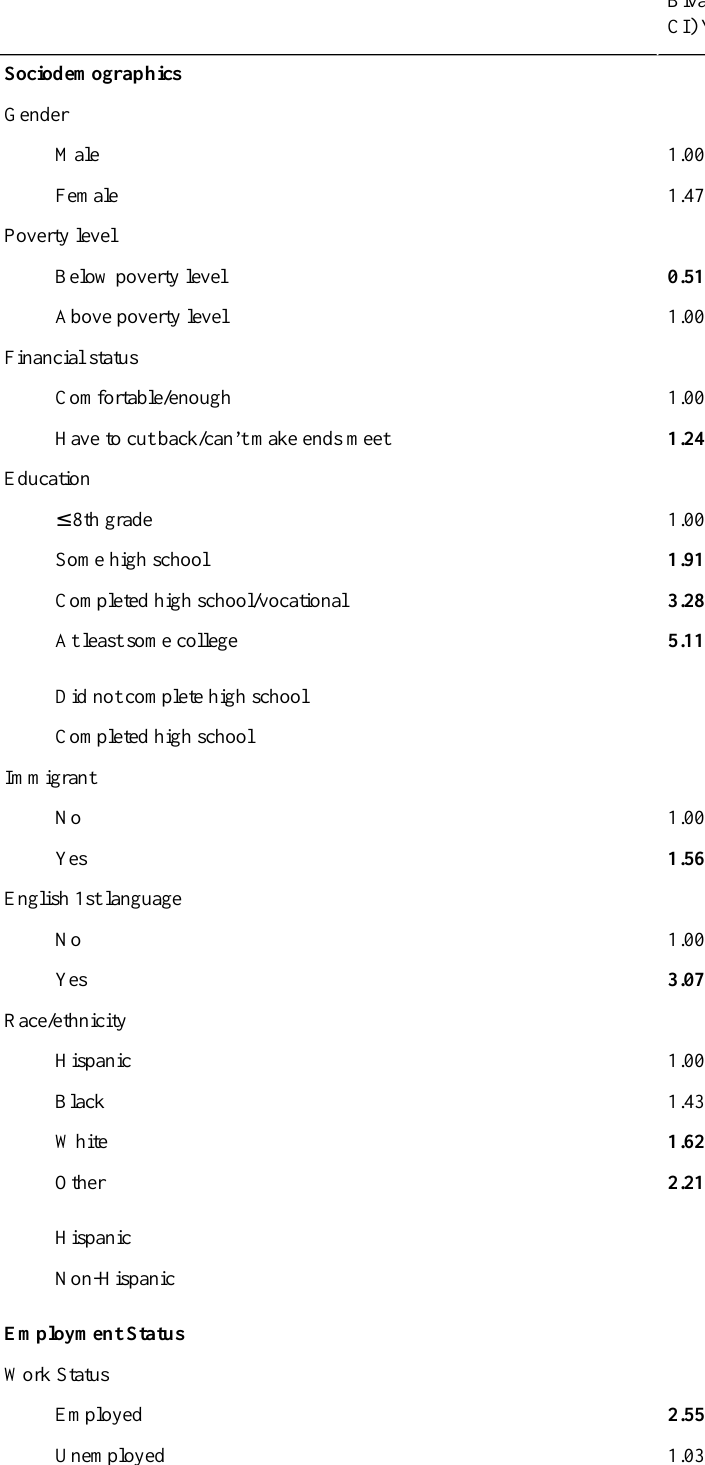
Multivariable-Adjusted OR